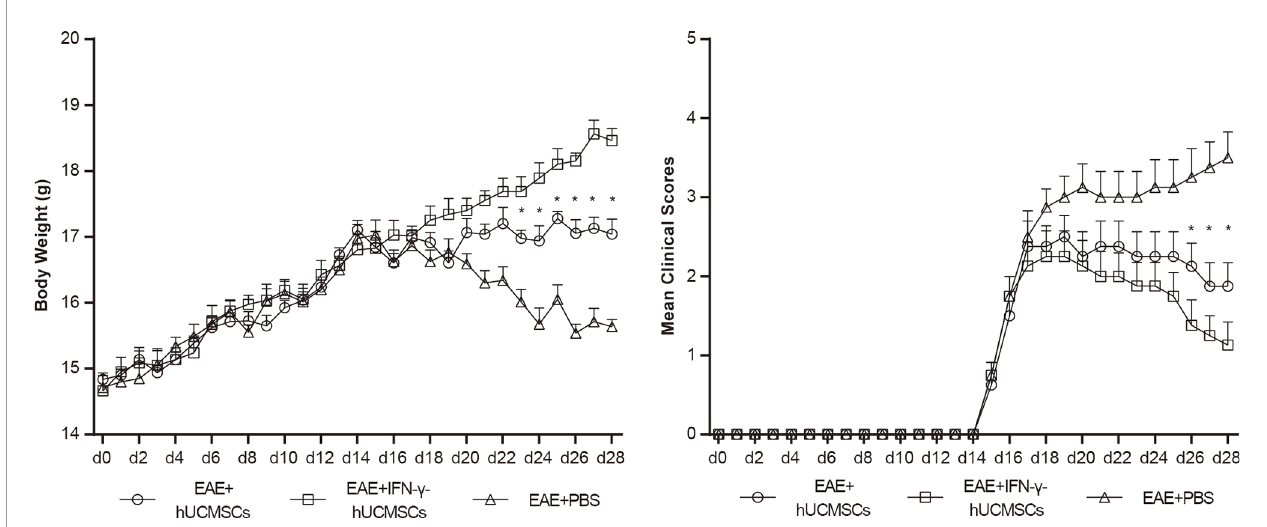
FIGURE 1 | Effects of transplantation of human umbilical cord mesenchymal stem cells (hUCMSCs) and IFN- g -primed hUCMSCs (IFN- g -hUCMSCs) on the body weights and clinical scores of experimental autoimmune encephalomyelitis (EAE) mice. Transplantation of hUCMSCs and IFN- g -hUCMSCs signi fi cantly alleviated the body weight loss and clinical scores of mice, especially in the IFN- g -hUCMSCs transplantation group. * p < 0.05 ( n = 8 per